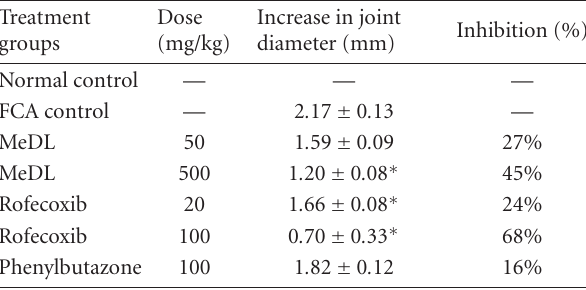
Table 1: Inhibition of joint inflammation by various drugs in FCA- induced monoarthritis. Values given are mean ± SEM ( n =